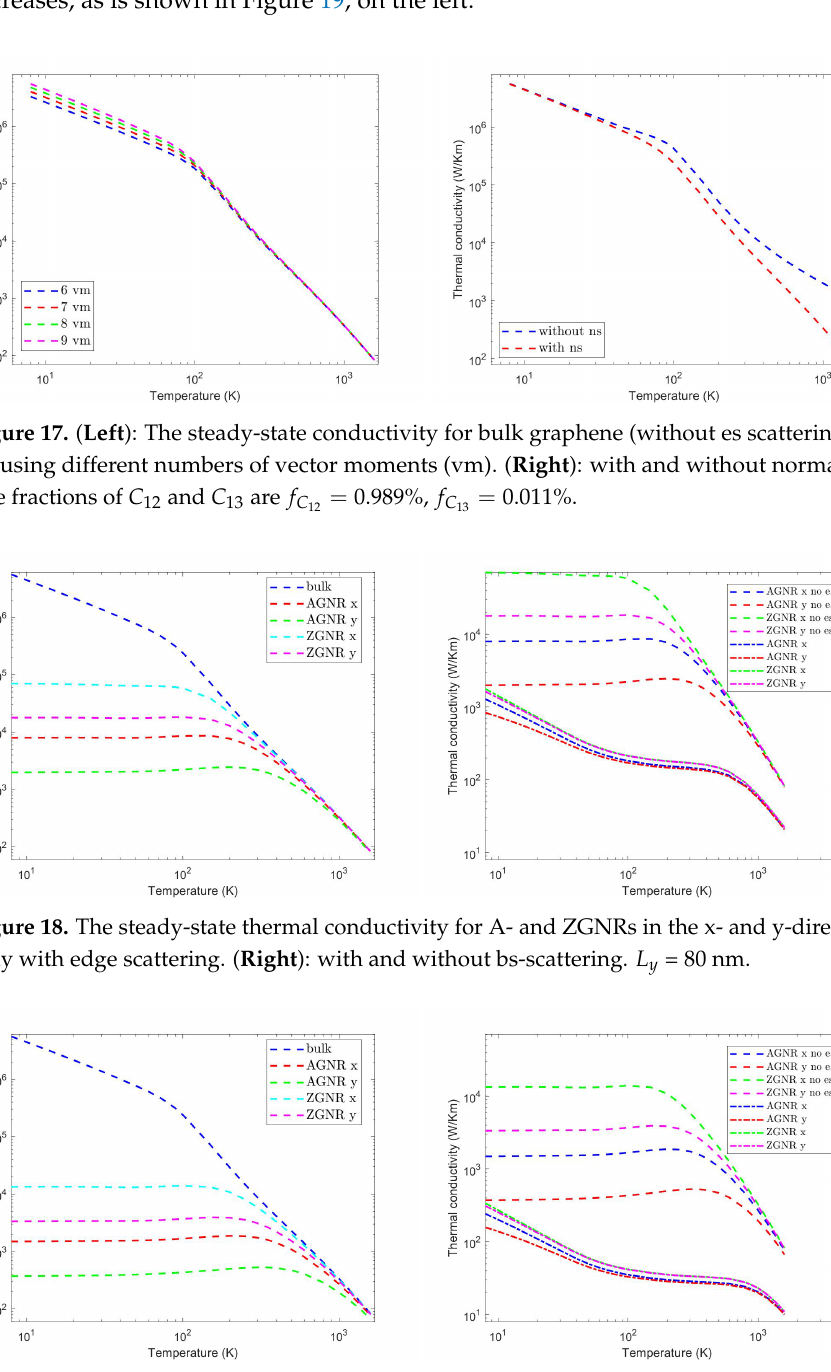
Figure 19. The steady-state thermal conductivity for A- and ZGNRs in the x- and y-direction. ( Left ): only with edge scattering. ( Right ): with and without bs-scattering. L y = 15